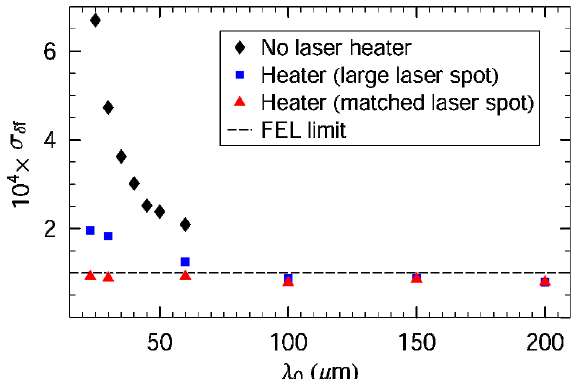
FIG. 13. (Color) Slice rms energy spread (cid:27) entrance at 14 GeV for 1% initial density modulation without a laser heater (black), in presence of a laser heater with a large spot size (blue), and with a matched spot size